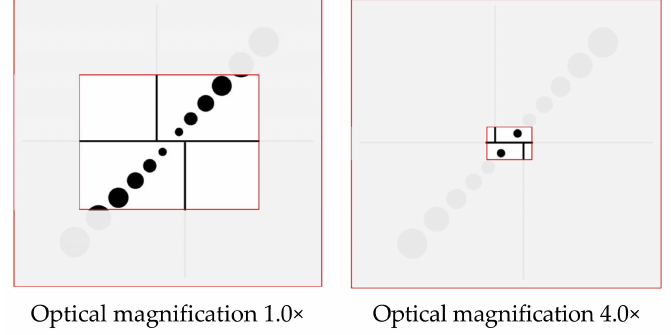
Figure 8. The field of view with di ff erent optical magnification.